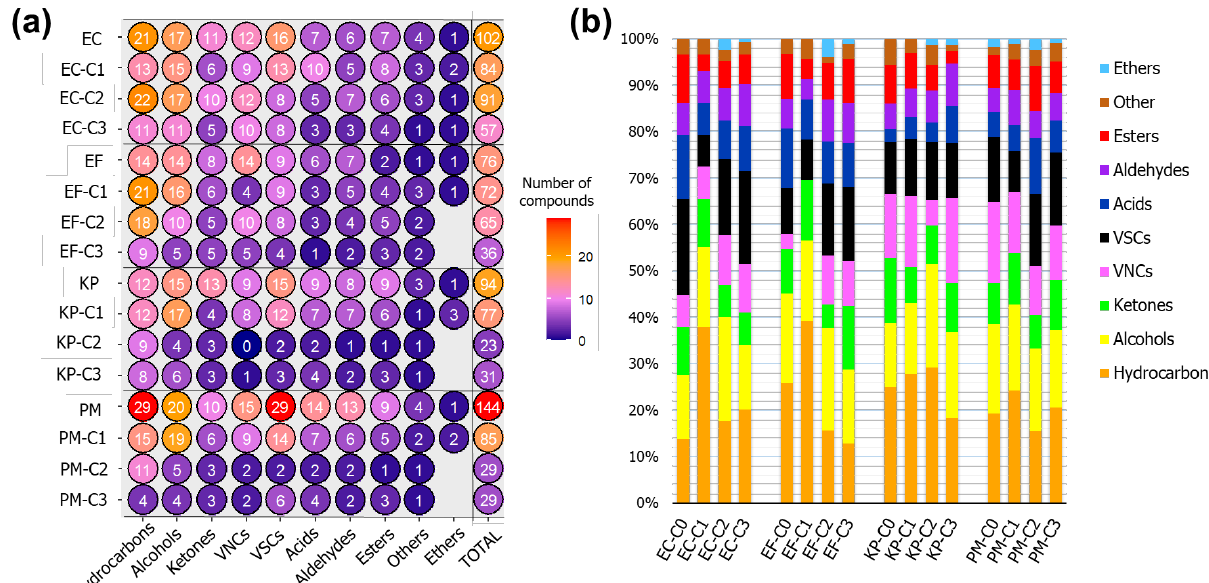
Figure 5. ( a ) Plot displaying the number of compounds detected in each of the performed experiments, according with functional group—the color scale refers to the range from lower (dark blue) to greater (red) incidence of VOCs; ( b ) bar plot presenting the proportion of VOCs detected referring to the respective chemical classes. EC = E. coli , EF = E. faecalis , KP = K. pneumoniae , PM = P. mirabilis .